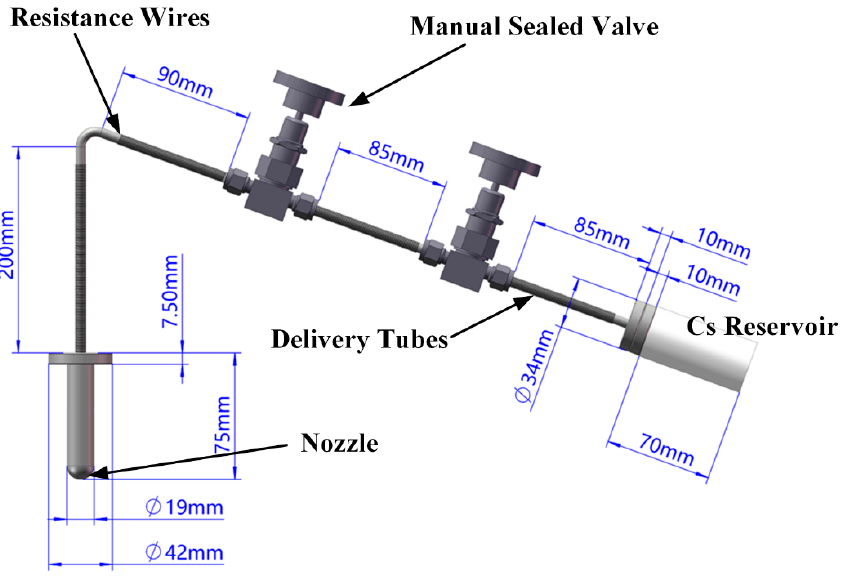
Figure 2. The schematic diagram of the heater.